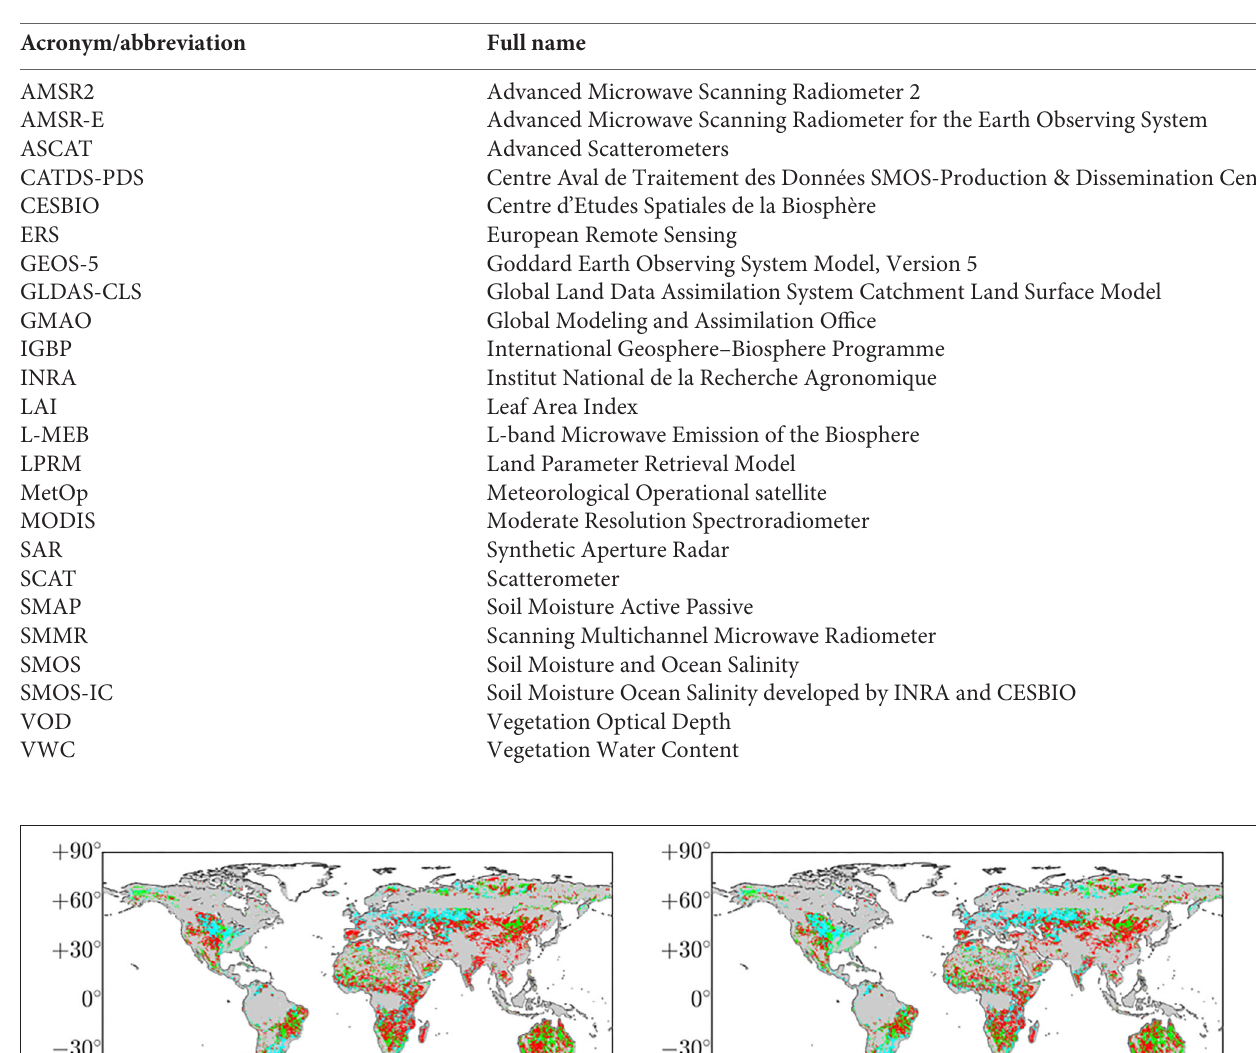
Frontiers in Water |